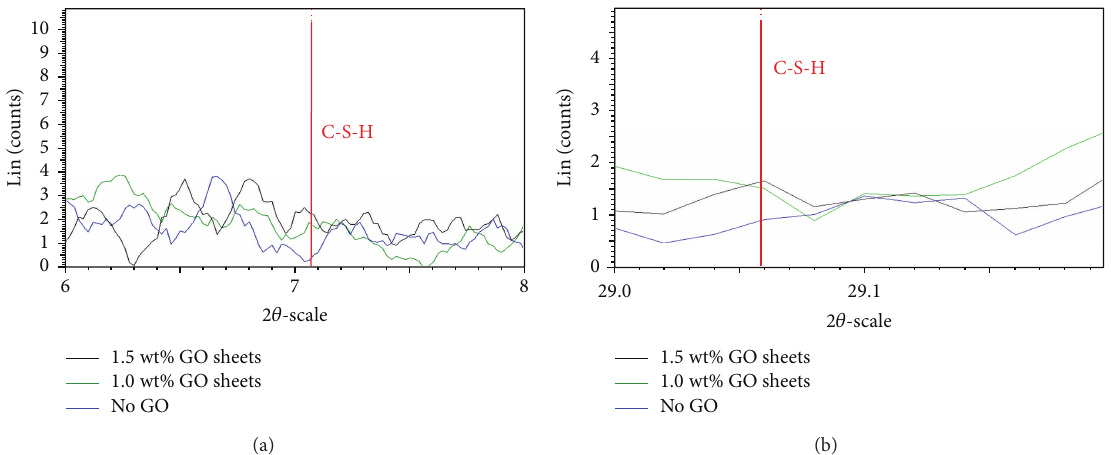
Figure 13: Comparison of X-ray diffraction data obtained from GO-cement nanocomposites containing 1 and 1.5wt% GO flakes and control sample (without any GO flakes) after 28 days (enlarged view).